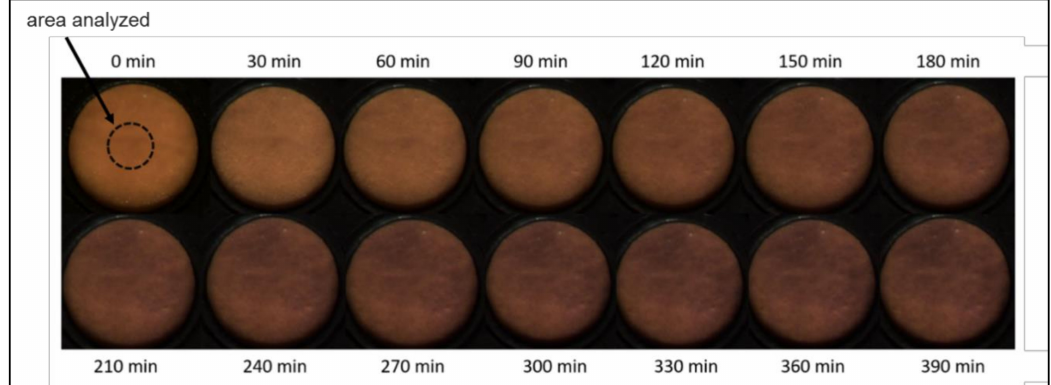
Figure 2. Set-up of optical measuring devices in the upper drying chamber [18].